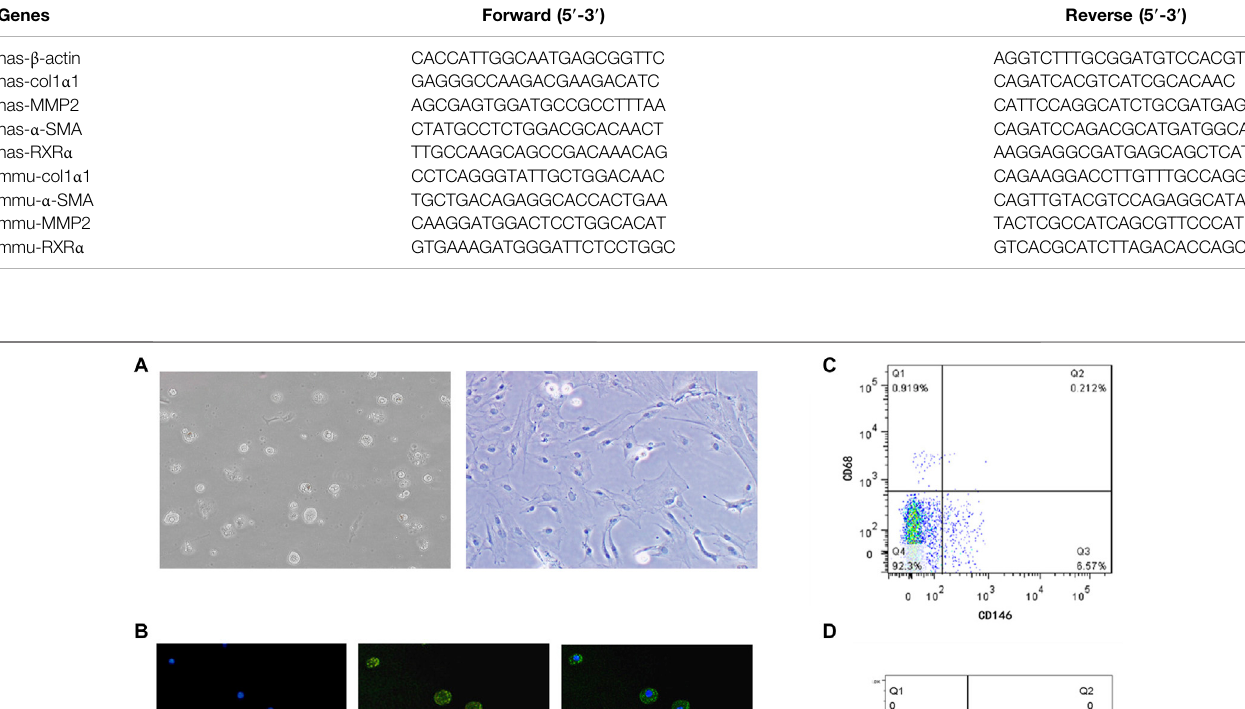
TABLE 1 | Primers used for the real-time polymerase chain reaction.